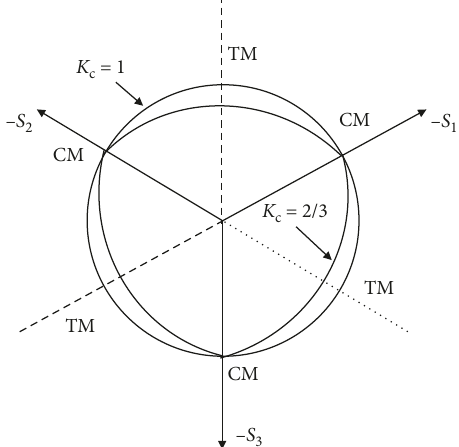
Figure 17: Yield surface in plane stress state [51].